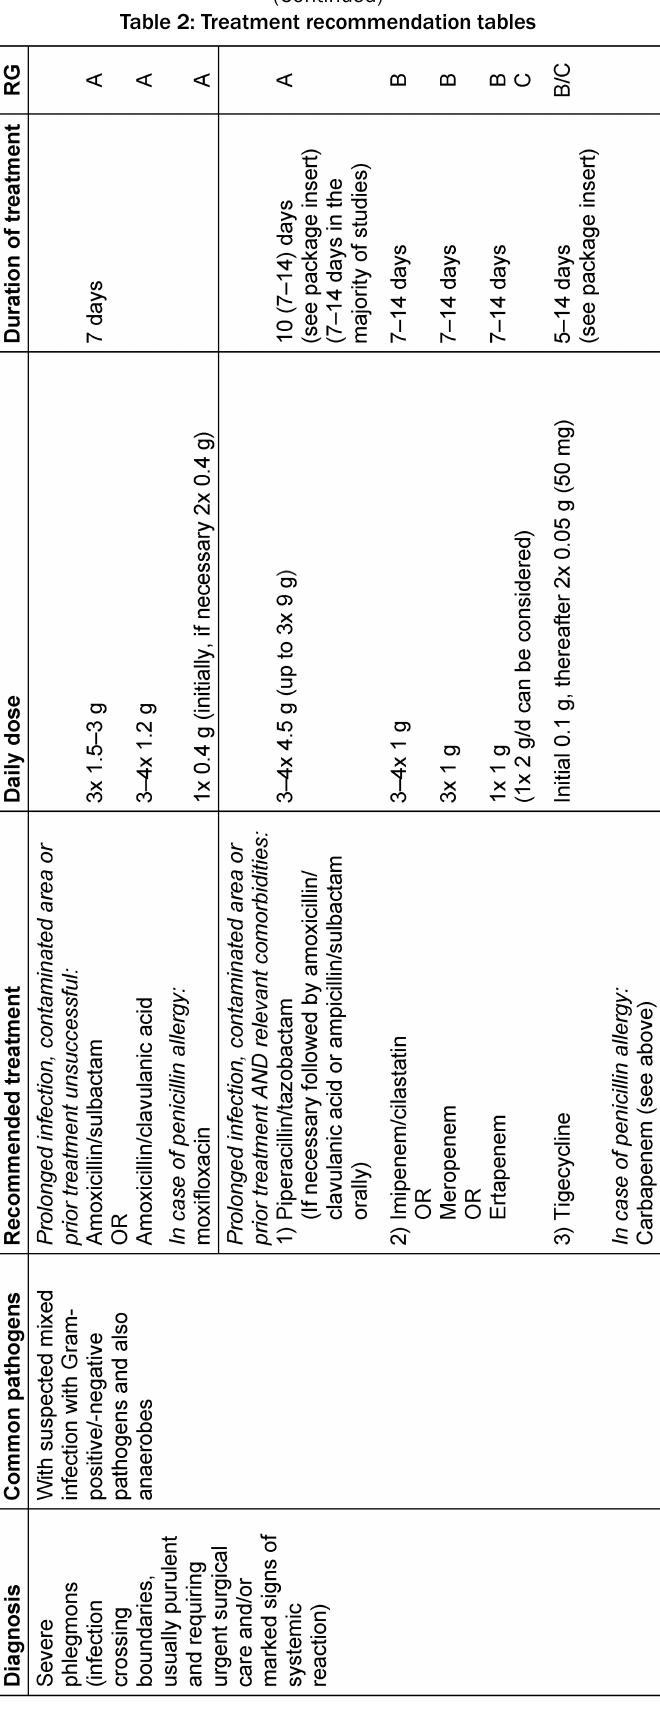
Table 2: Treatment recommendation